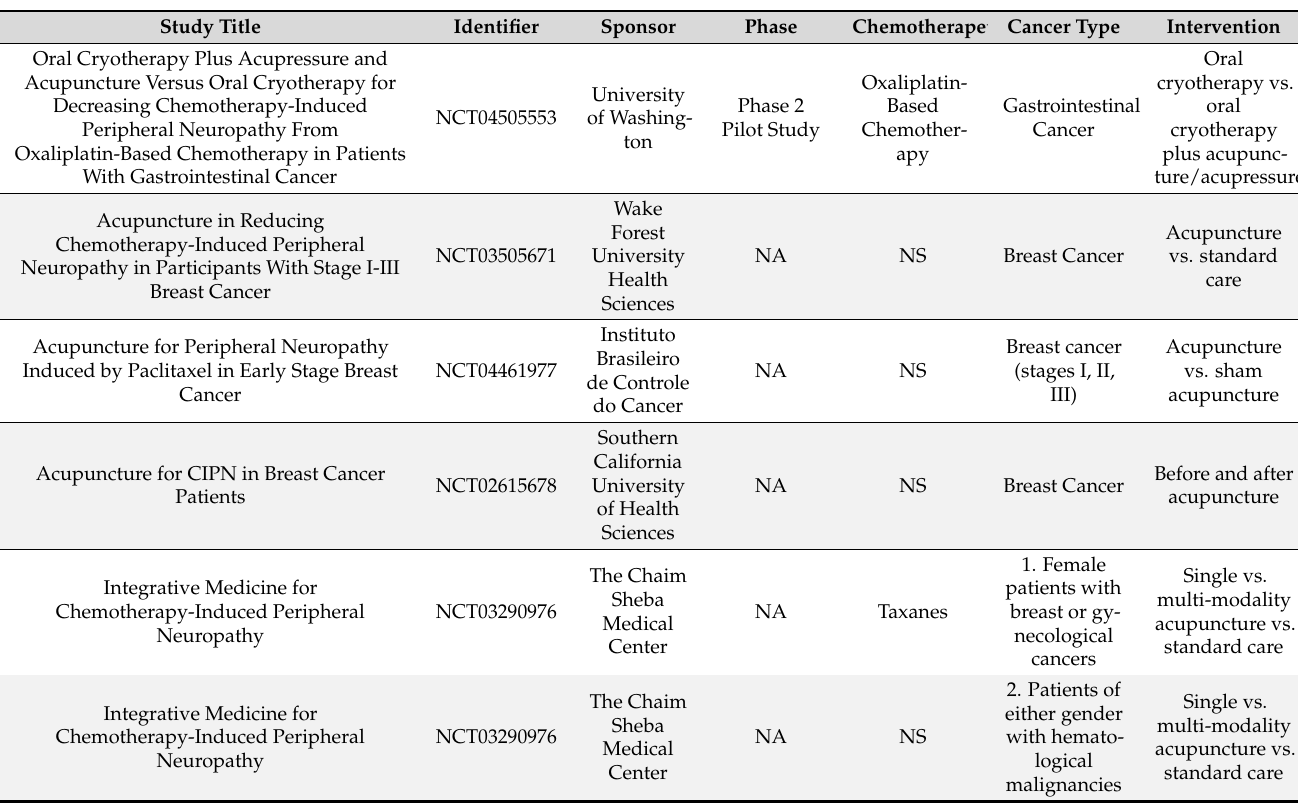
Table 3. Current complete or active acupuncture clinical trials for chemotherapy-induced peripheral neuropathy